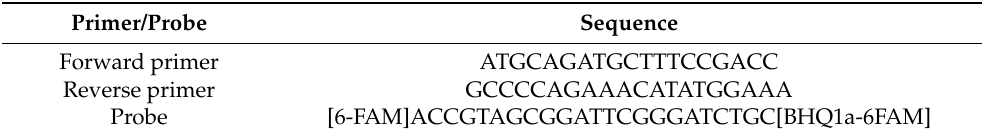
Table 1. Primer and probe sequences used for qPCR in this